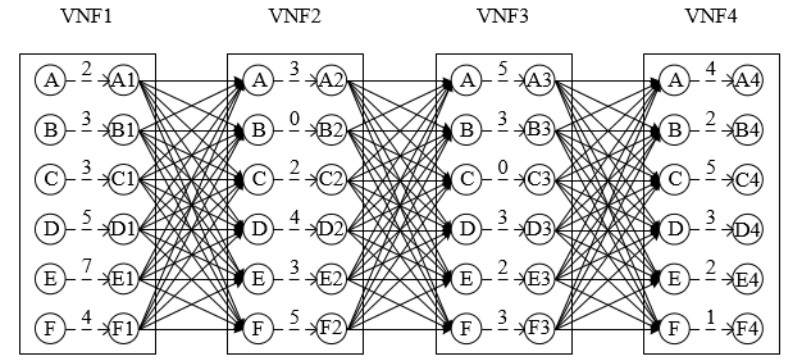
Figure 5. Multilevel overlay directed network